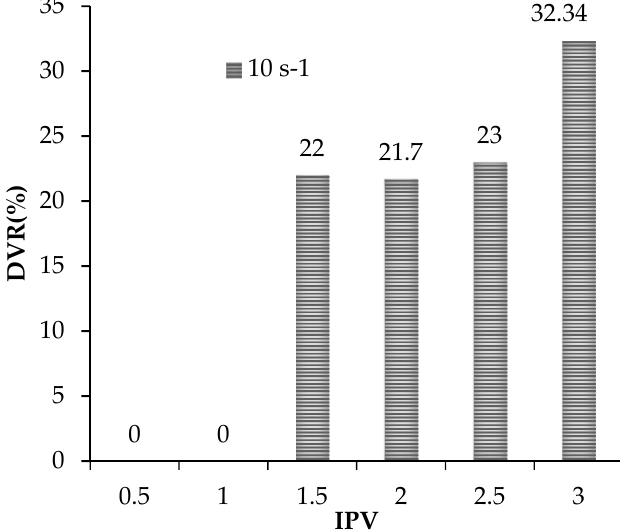
Figure 16. DVR% for the different porous volumes produced in the dynamics tests carried out in the Castilla oil field porous media with original FF and optimized NanoFF.